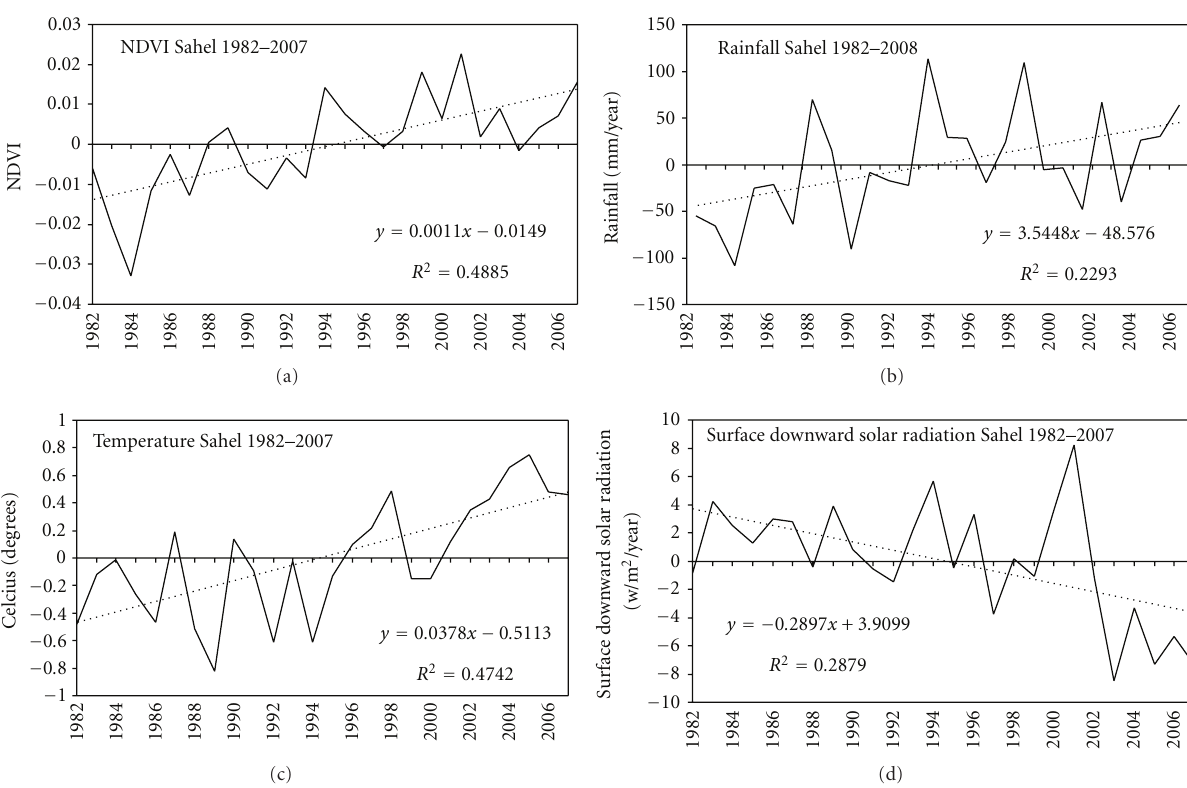
Figure 4: Linear trend analysis Sahel 1982–2007 of (a) GIMMS NDVI anomalies, (b) CMAP rainfall anomalies, (c) NCEP GHCN/CAMS gridded air temperature, and (d) NCEP-DOE gridded surface downward solar radiation flux anomalies. Anomalies are with respect to the 1982–2007